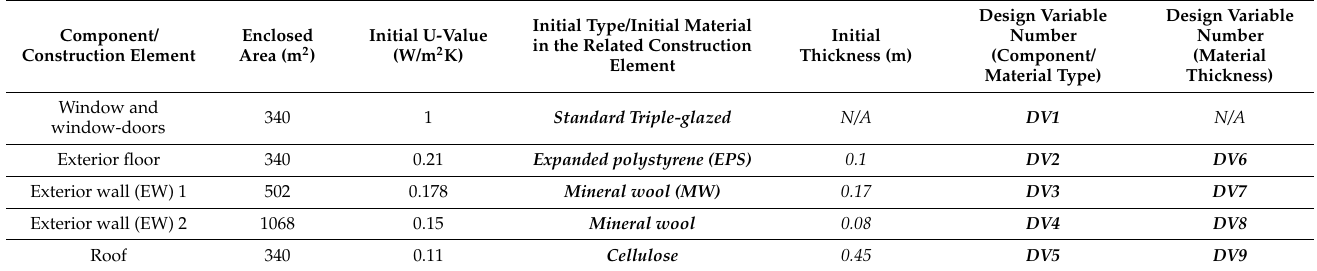
Table 1. The windows and construction elements related to the as-built design of the high-rise apartment building, as well as the design variables related to the passive energy efficiency measures that were subjected to optimization (i.e., components and materials that are highlighted in bold italics).